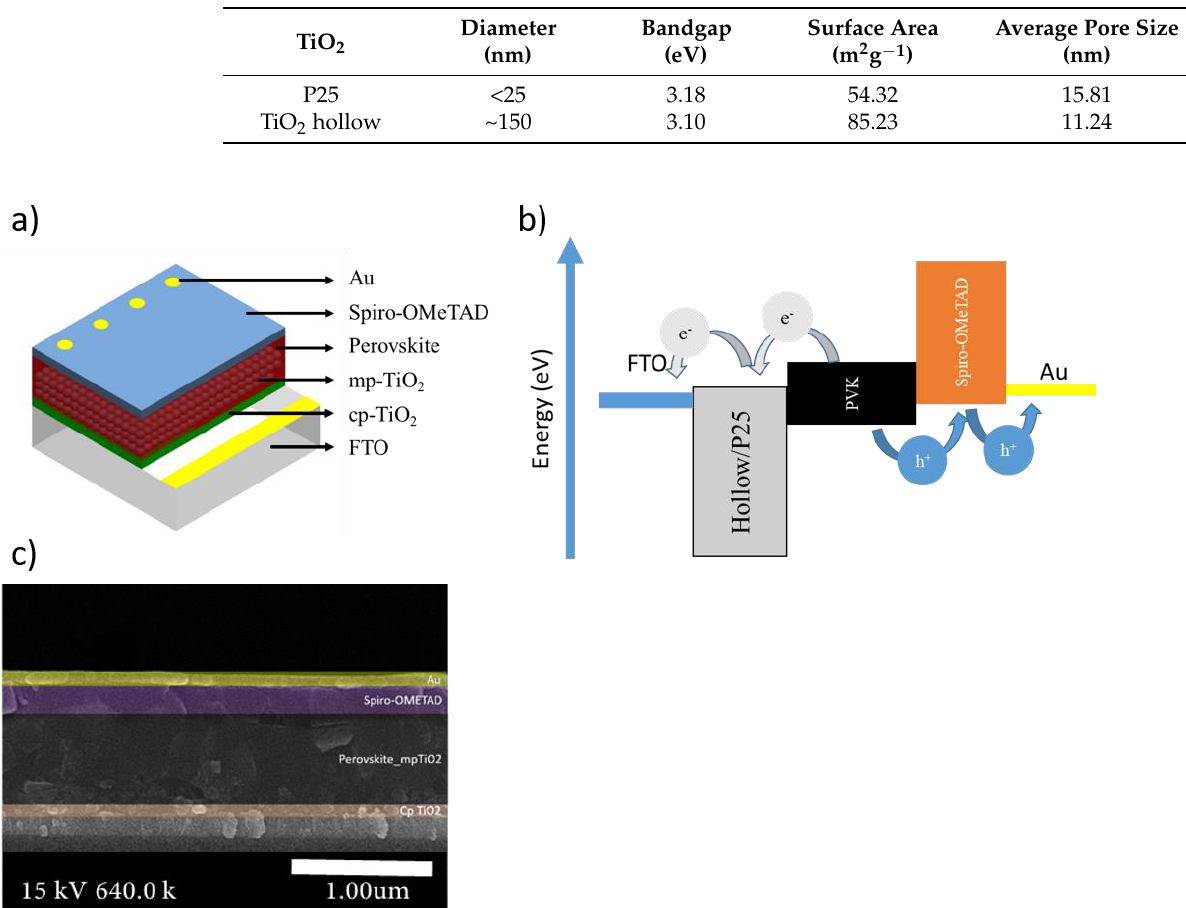
Table 2. The photovoltaic performances of the PSCs under sunlight illumination of 100 mWcm −2